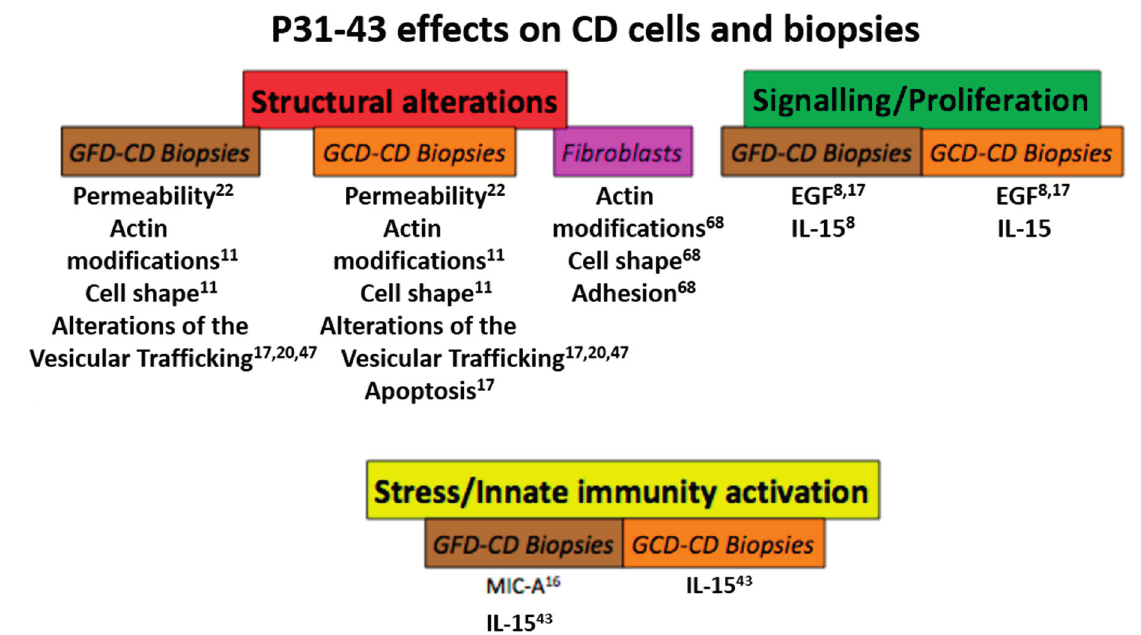
Figure 2. P31–43 affects cells and biopsies from celiac disease (CD) patients. Schematic representation of the effects of gliadin peptide P31–43 on CD cells and biopsies. The main effects were grouped in three sets: structural alterations (permeability, actin modifications, cell shape and transport/trafficking), signaling/proliferation (EGF/EGFR-IL-15/IL-15R- α activation, pY-ERK) and stress/innate immunity activation as shown. In all cases, there was a quantitative increase in the markers cited, although in the case of actin, the alterations were qualitative. Numbers indicate the bibliographic references. GCD: gluten-containing diet. GFD: gluten-free